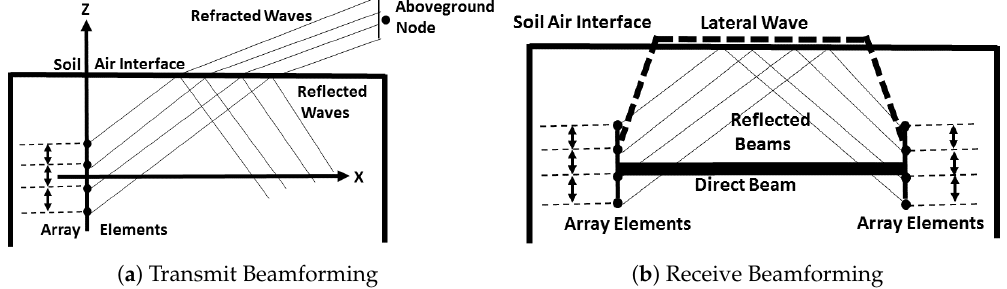
Figure 2. The communications schematic for UG MIMO. ( a ) Transmit Beamforming; ( b ) Receive